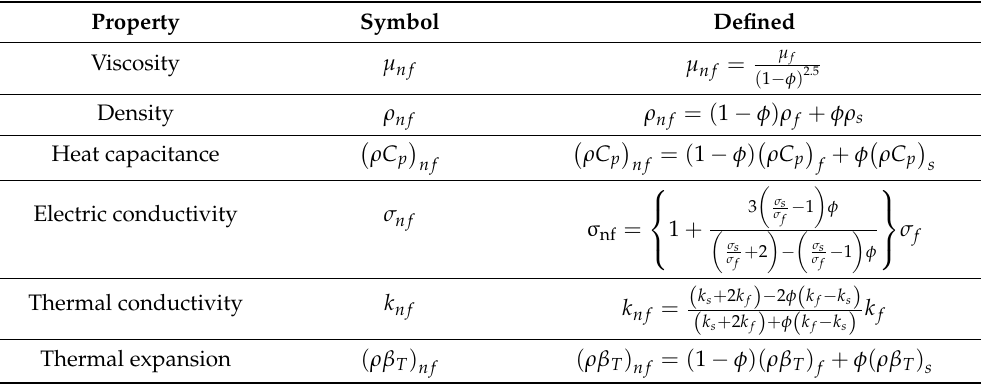
Table 1 represents thermophysical properties of important variables of nanofluids. Table 1. Thermophysical properties of the nano fluid